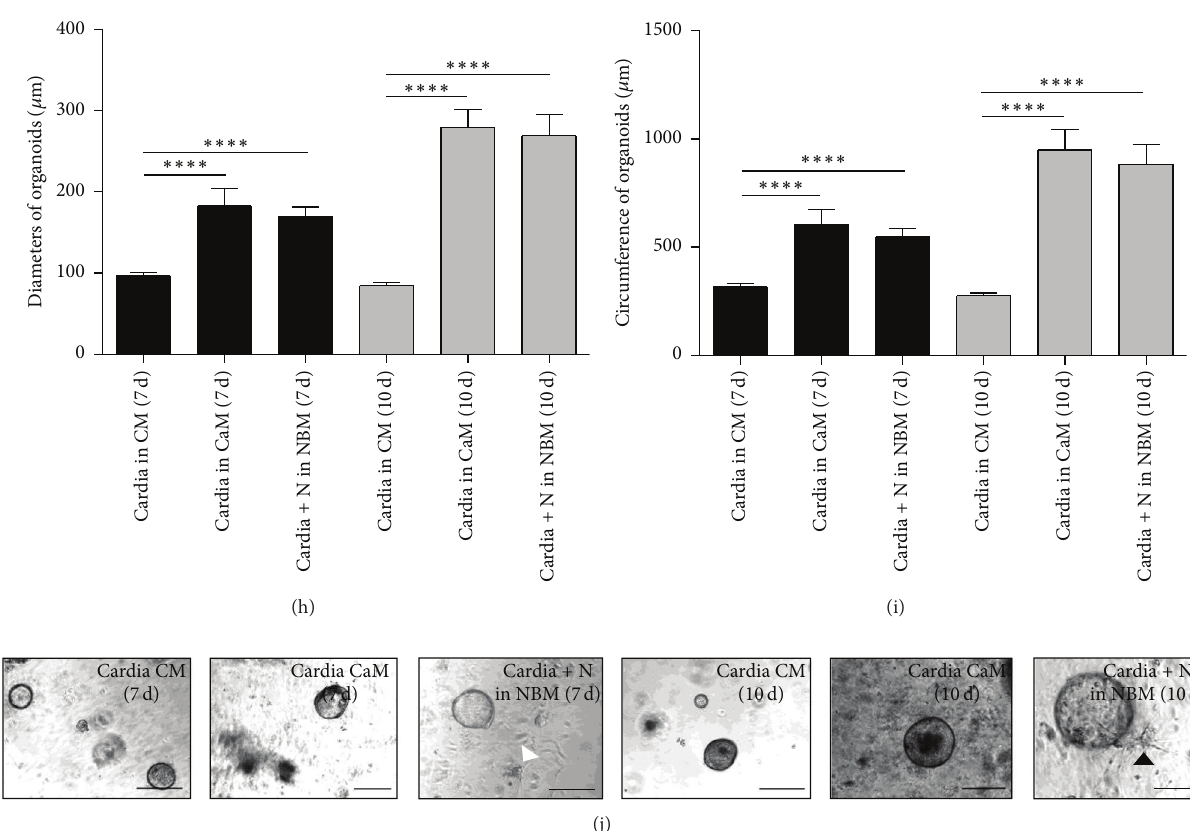
Figure 6: Cardia organoid cultures and cocultures with neurons as a model to investigate the gastrointestinal stem cell niche. (a) IHC for H&E, PAS, Ki-67, and 𝛼 -SMA for further characterization of the method, arrowheads indicating positive stained cells, scale bars, 100 𝜇 m. (b) Light microscopy of Lgr5-GFP-positive organoid, scale bar, 50 𝜇 m. (c) Immunofluorescence of Dclk1-labeled neurons in cultured conditions (NBM). (d) Cultured neurons (NBM) stained with beta-III Tubulin, scale bar, 100 𝜇 m. (e) Cocultured neuron with cardia organoid, light microscopy and immunofluorescence, ∗ Dclk1-labeled neuron (green fluorescence) neighboring crypt wall, scale bar, 100 𝜇 m. (f) Ca-imaging of neuron in cocultured conditions (NBM), different points in time beginning from application of nicotinic acid to Fluo-4-labeled neurons, brightening of neuron indicating Ca-influx. Scale bar, 50 𝜇 m. (g) Analysis of the RLI of stimulated neuron, ROI I, ROI II, and ROI III measuring different regions of the neuron as indicated in (f), picture 2 (regions labeled 1, 2, and 3). ((h), (i)) Analysis of organoids and cocultured neurons in different conditions, distribution of mean diameters and circumferences per group and point in time and standard error of the mean (SEM) (CM = crypt medium, CaM = Wnt-conditioned cardia medium, NBM = cocultured neurons in neurobasal complete medium, groups compared at 7d and 10d), measured in 𝜇 m; comparison of average organoid growth between groups applying two-tailed 𝑡 -test ( ∗ level of statistical significance, ∗∗∗∗ 𝑃 < 0.0001 ), 𝑛 = 3 experiments per group and point in time. (j) Representative light microscopic image of each group and point in time (arrowheads indicating neurons), scale bar, 100 𝜇